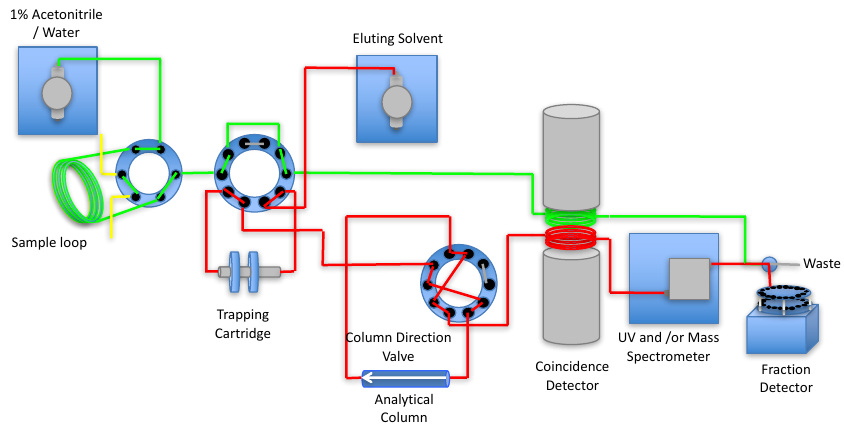
Figure 6. If the pressure of the analytical column exceeds the set pressure limit, the 10-port column direction valve V3 is switched, the analytical column flow is reversed to remove materials obstructing the flow of solvent. Once the pressure drops the valve is switched and the flow returned to normal flow, as per Step